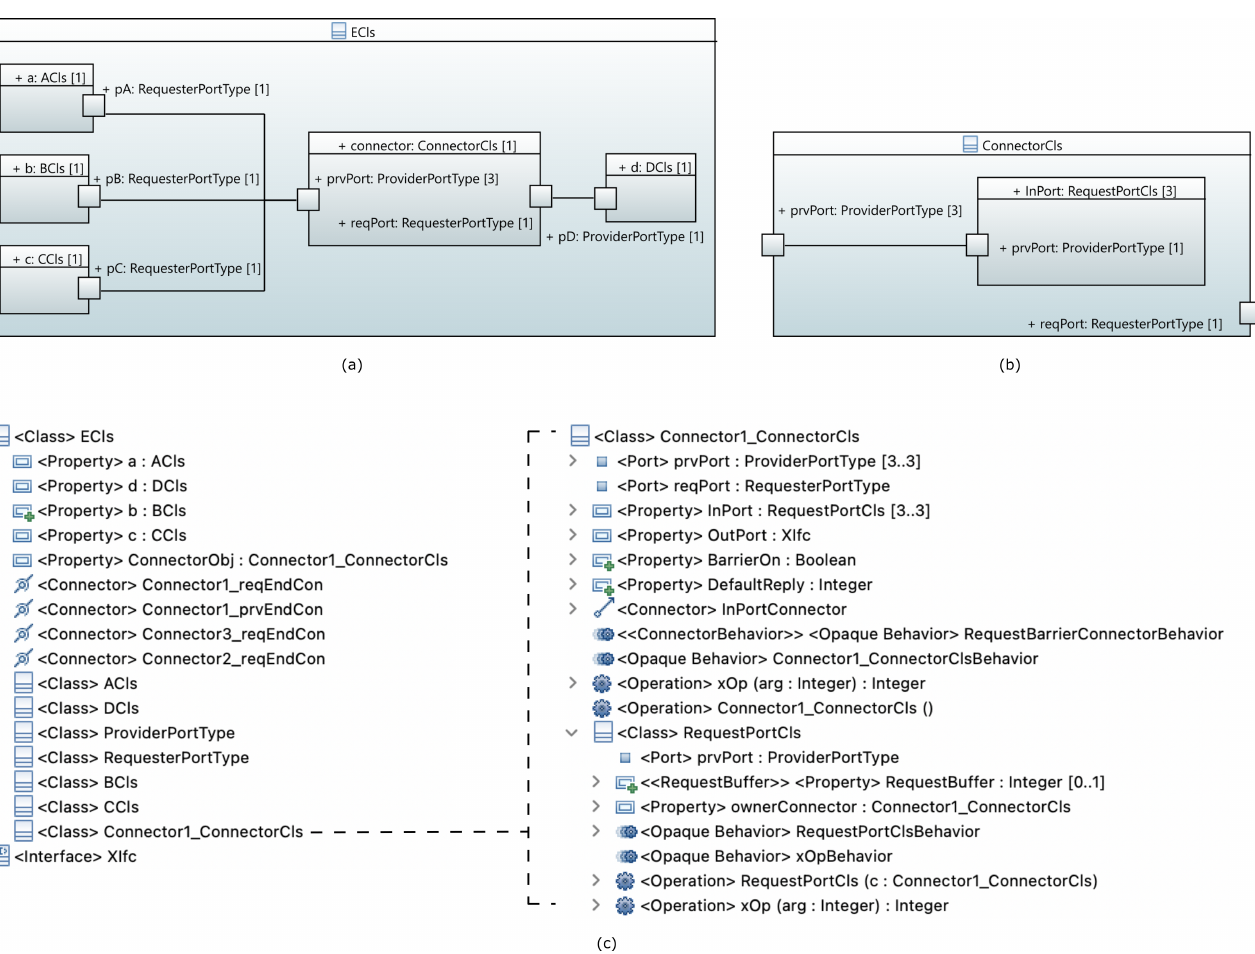
Figure 13. E2 level composite structure diagrams and UML models for the request barrier connector: ( a ) Composite structure diagram for the request barrier connector. ( b ) Composite structure diagram for the connector class. ( c ) E2 level UML